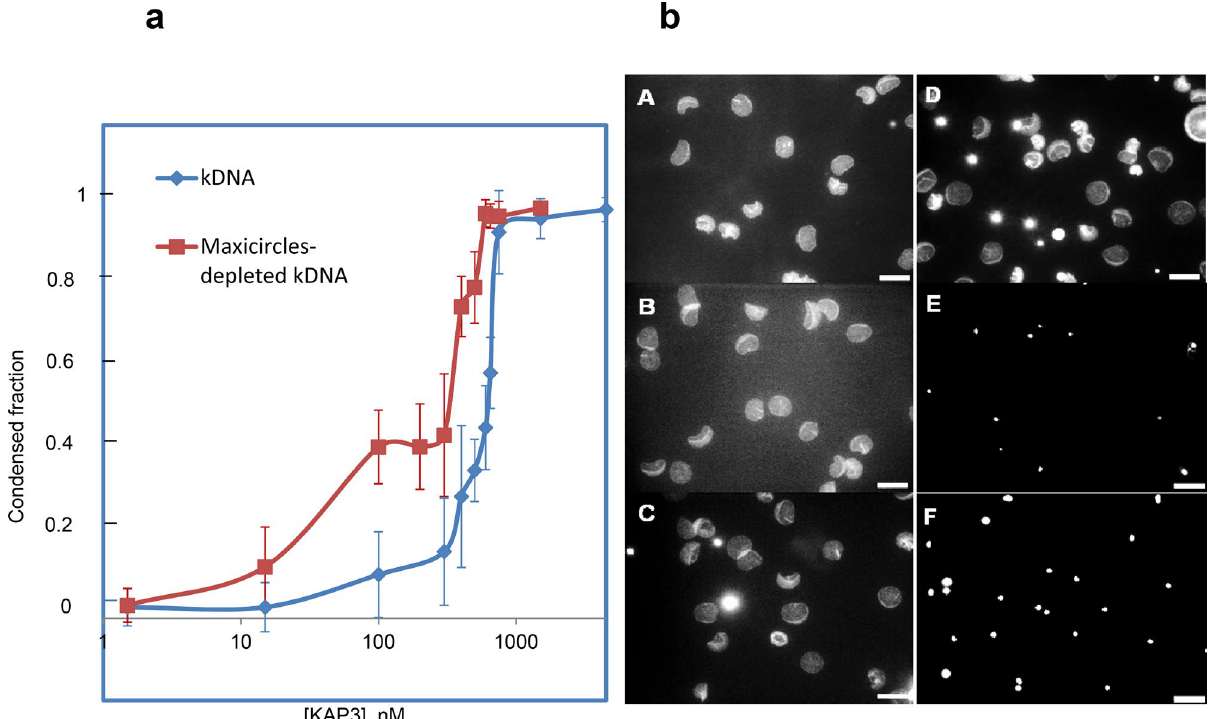
Figure 3. Condensation of kDNA by KAP3. (a) Quantification, by fluorescence microscopy, of the condensation of kDNA networks was performed at different KAP3 concentrations (presented on a logarithmic scale) at the range of 1.5–1500 nM, either with native-kDNA networks (blue line) or maxicircles depleted networks (minicircles-kDNA) (red line). Each point in the curves is based on the count of ~ 600 networks. (b) A sample of images demonstrating, (A) uncondensed kDNA networks; (B–F) condensation of kDNA networks by 1.5, 100, 500, 750, 1500 nM KAP3, respectively. Bars are 10